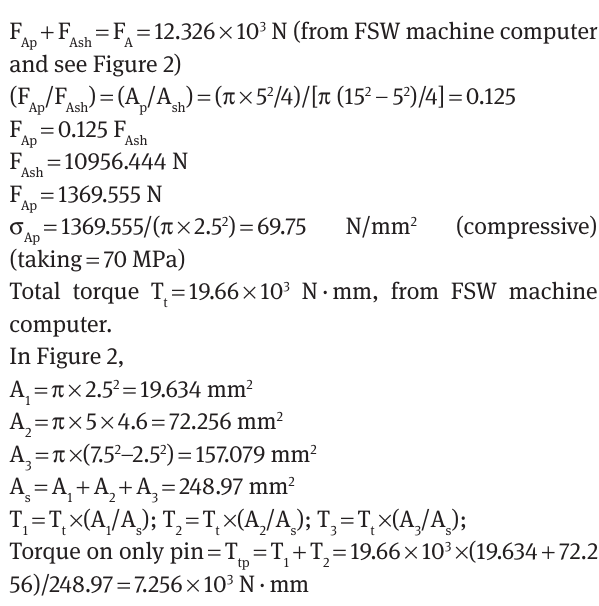
Figure 2: FSW tool with various quantities. 2 mm From Figure 2,